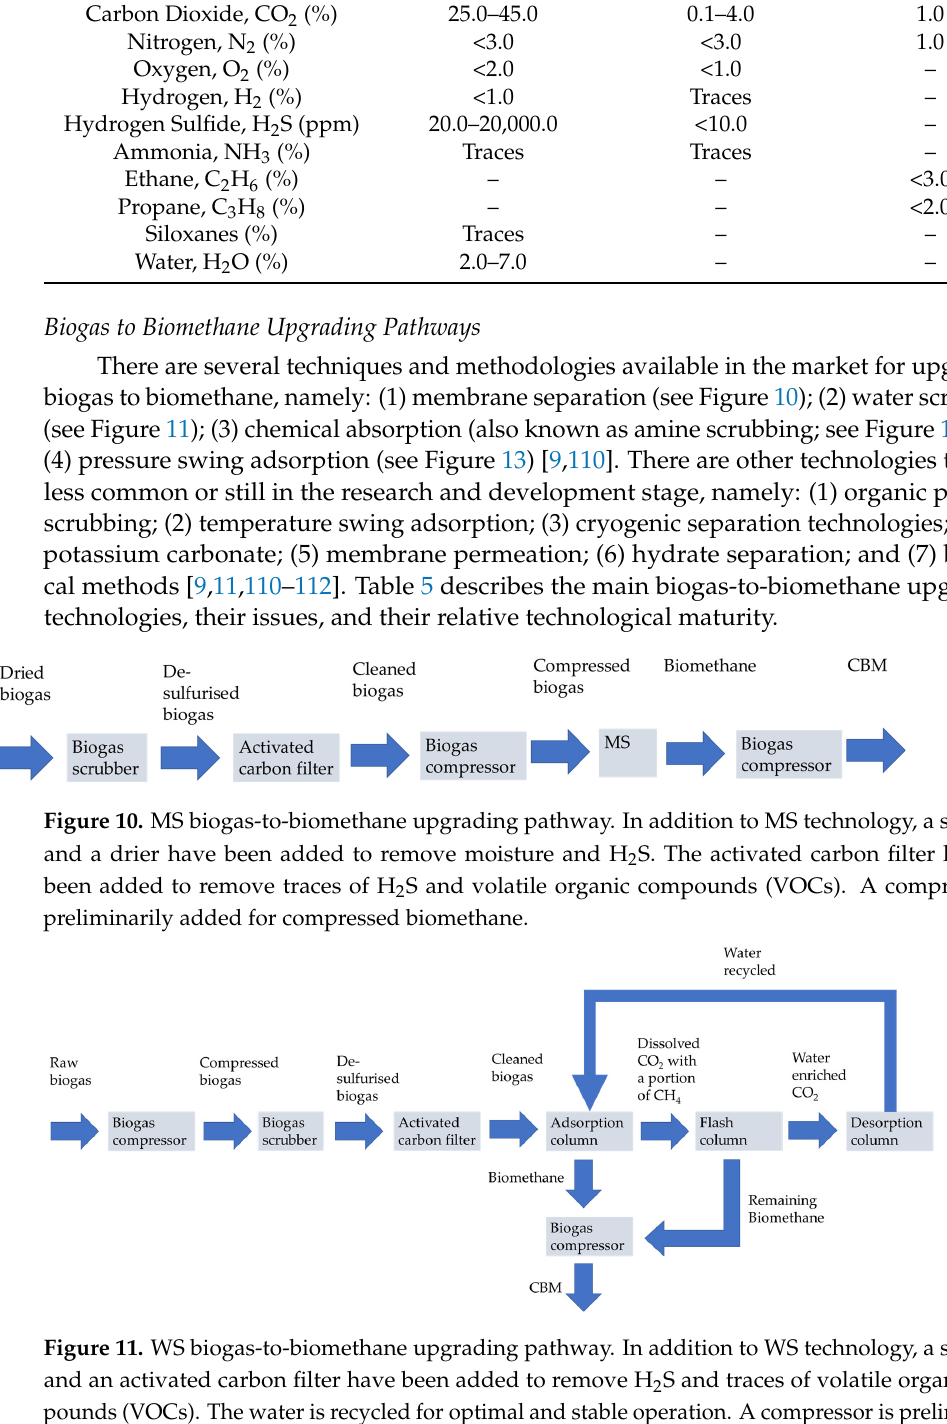
Figure 11. WS biogas-to-biomethane upgrading pathway. In addition to WS technology, a scrubber and an activated carbon filter have been added to remove H 2 S and traces of volatile organic com- pounds (VOCs). The water is recycled for optimal and stable operation. A compressor is prelimi- narily added for compressed biomethane.